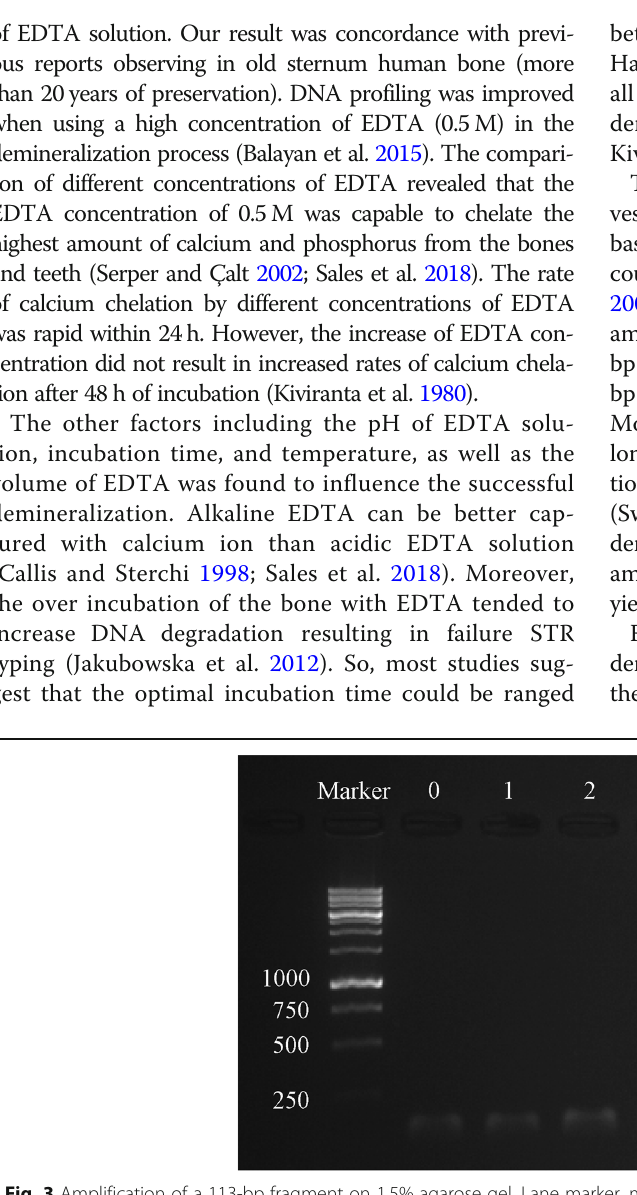
Fig. 3 Amplification of a 113-bp fragment on 1.5% agarose gel. Lane marker, molecular weight marker and lanes 0 – 13, and 4 μ l of bone from different demoralization process (from experimental groups 0, 1, 2, 4, 8, 9, and 13) were used as a